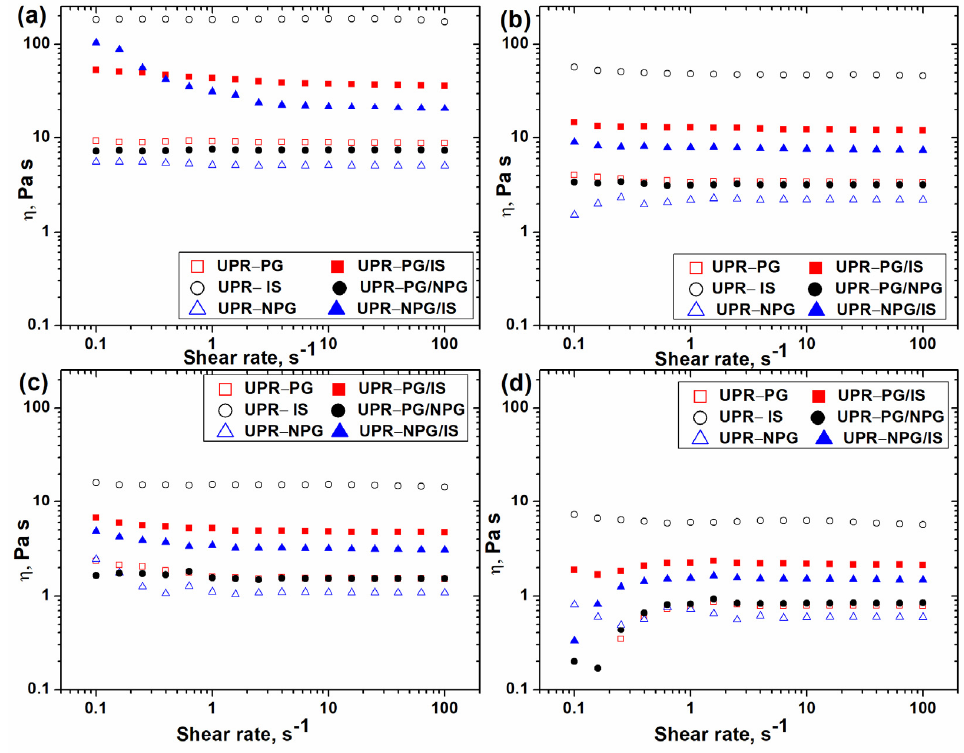
Figure 2. The viscosity as a function of the shear rate of the examined UP resins measured at: ( a ) 25 °C; ( b ) 35 °C; ( c ) 45 °C; and ( d ) 55 °C.